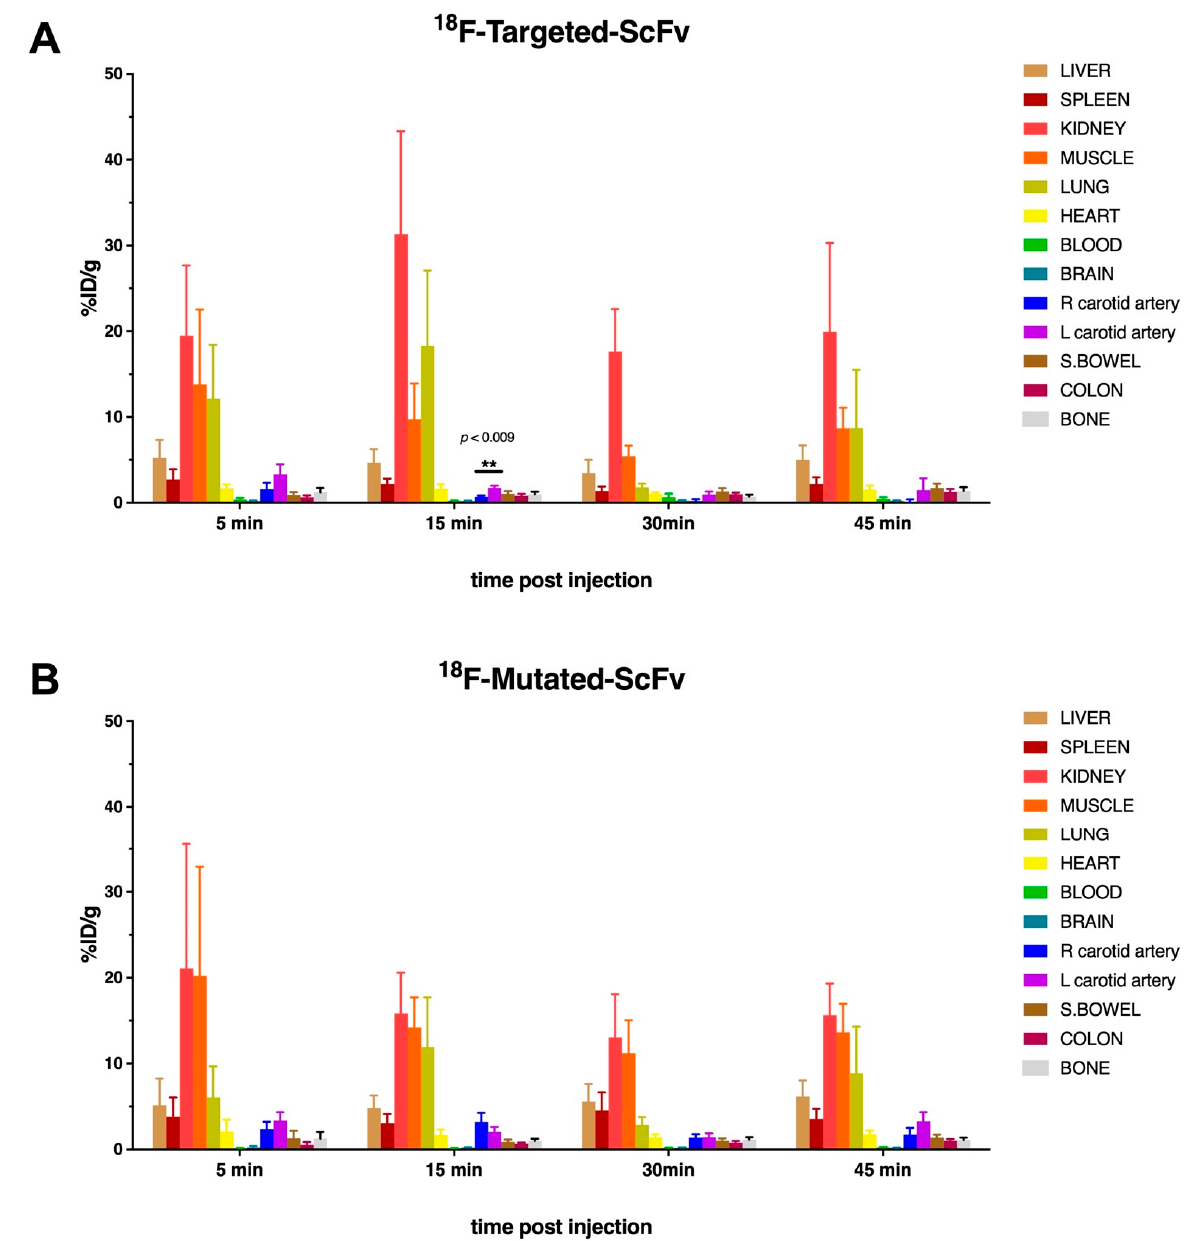
15 min after injection (Figure 3). All other time points examined revealed no significant dif- ference in the uptake of 18 F-targeted-ScFv between injured and intact vessels. Additionally, 18 F-mutated-ScFv showed no significant difference in radioactivity uptake between injured and intact vessels ( p > 0.05). (Figure 3).